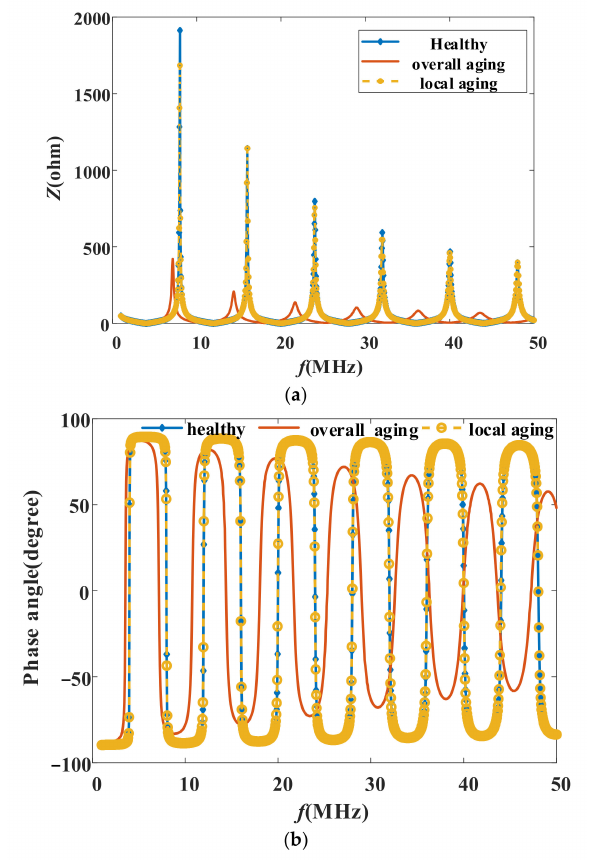
Figure 4. The impedance spectroscopy for healthy and aged cables: ( a ) the impedance magnitude spectroscopy and ( b ) the impedance phase